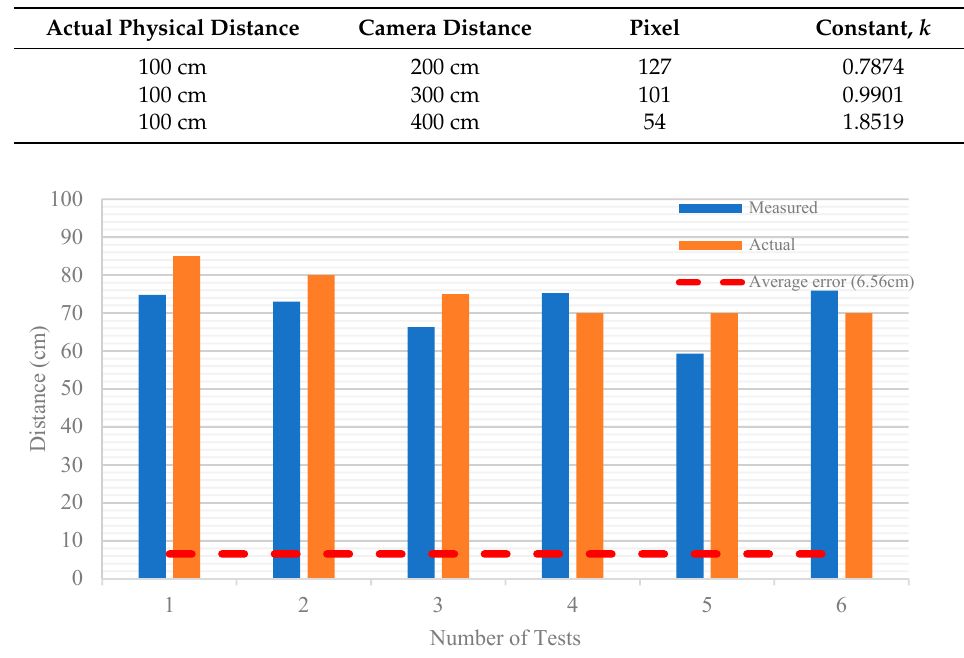
Figure 9. Measured versus actual distance of two people and the average error.